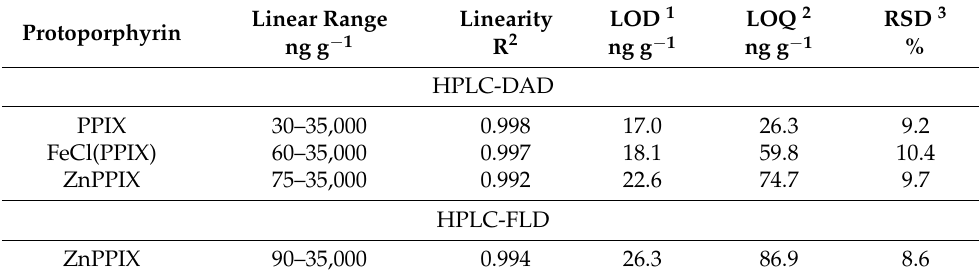
Table 2. Validation parameters for protoporphyrins calibration using HPLC-DAD-FLD.